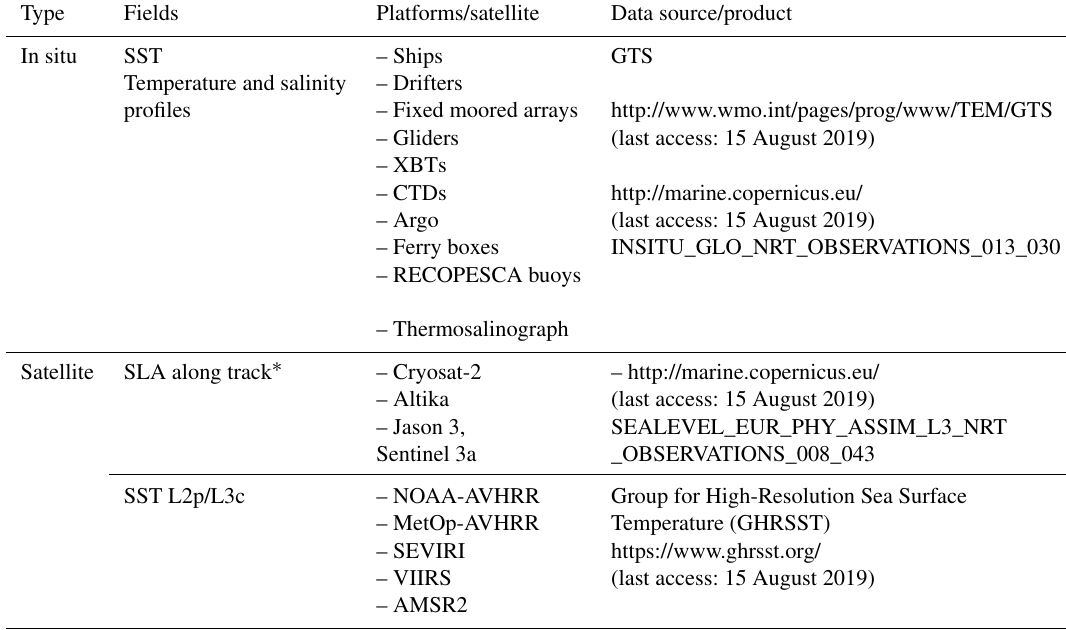
Table 3. List of observations used for data assimilation.